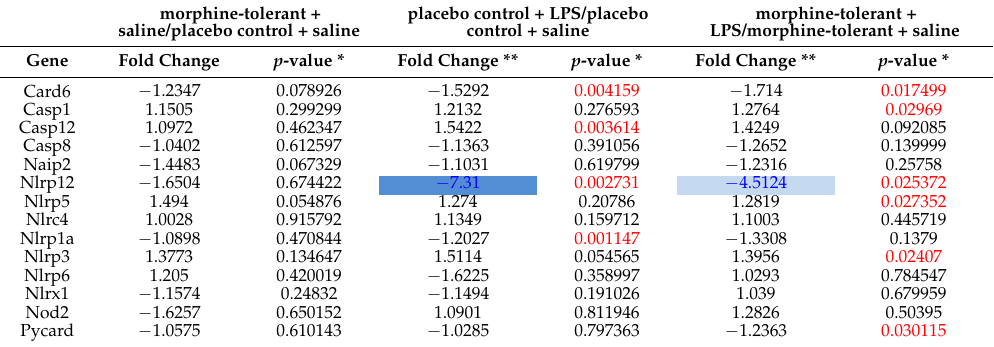
* For p -value, letters in red mean p < 0.05. ** For Fold Change, letters in red mean fold change >2 and letters in blue mean the fold change < − 2. For the color lines, : 6–10 fold decrease; : 2–5 fold decrease;